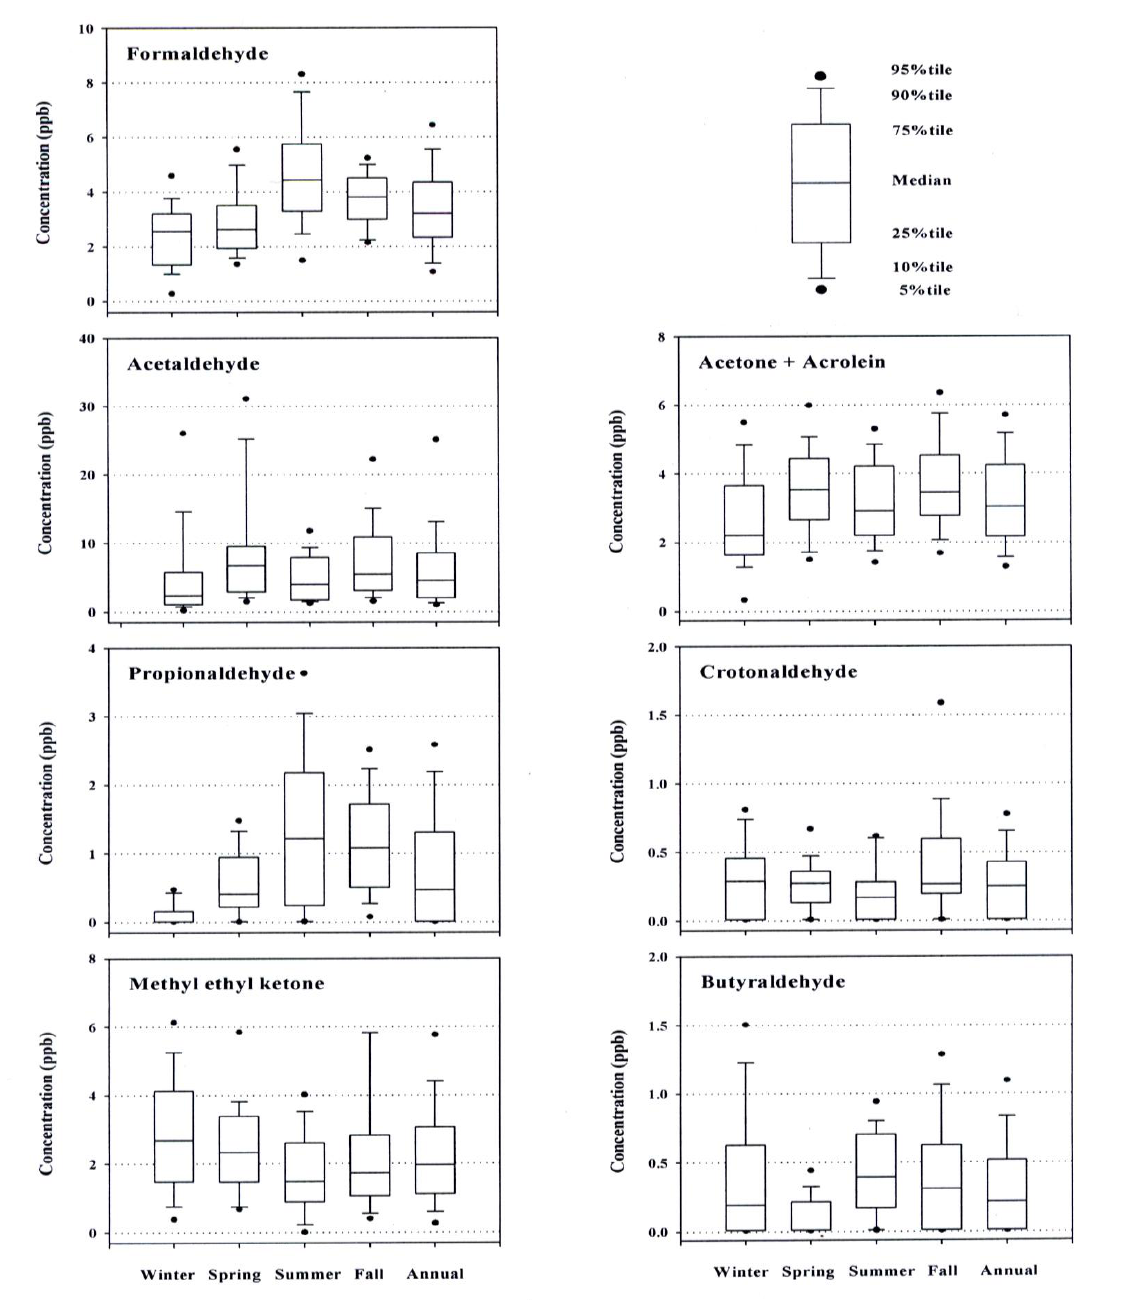
Figure 3. Seasonal concentrations of carbonyl compounds in the 1st industrial